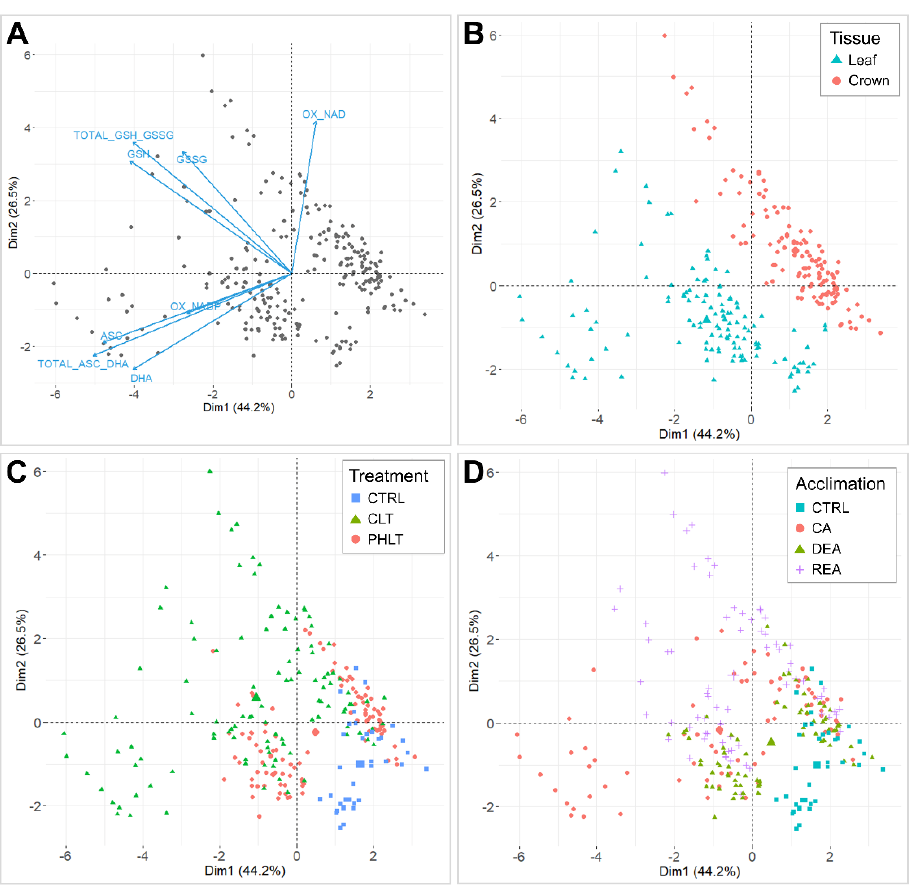
Figure 1. Principal component analyses (PCAs) of antioxidants, measured throughout the experiment. A biplot of individuals and variables, where positively correlated variables point towards the same direction ( A ). Biplot, grouped by tissue ( B ). Biplot, grouped by treatment ( C ). Biplot, grouped by stage of acclimation ( D ). The control (CTRL) sampling point preceded the acclimation treatments and was followed by cold acclimation (CA), deacclimation (DEA), and reacclimation (REA). CLT — constant low-temperature treatment during CA; PHLT — prolonged higher low-temperature treatment during CA.